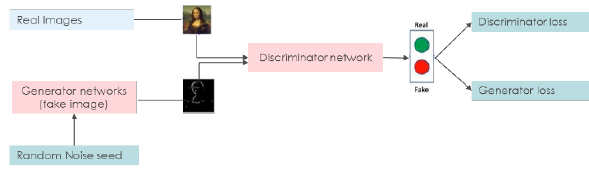
Figure 3 . Overview of the generative adversarial network.